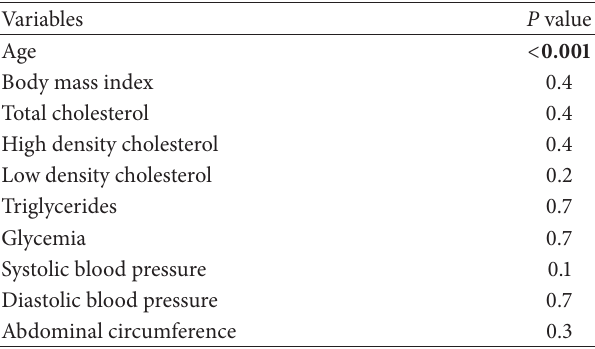
Table 4: Multivariate analysis for the presence of mild versus mod- erate + severe male LUTS as the dependent